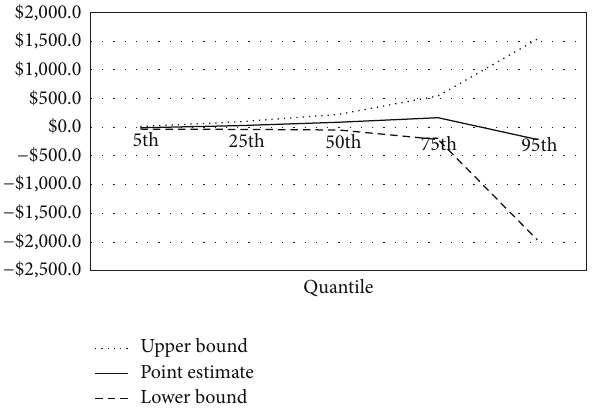
Figure 5: Weighted relationships between residence and nonzero total expenditure, adjusted by 10